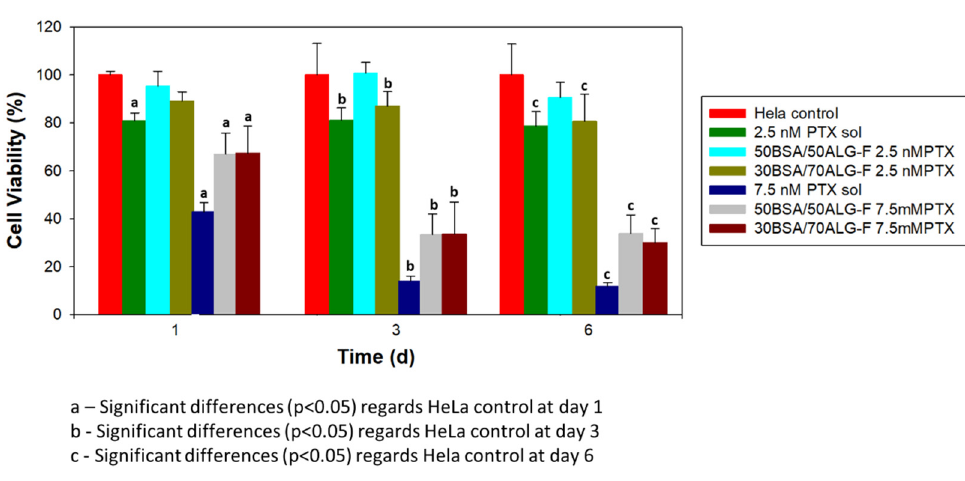
Figure 4. Cell viability of MCF-7, MDA-MB-231 and HeLa cells in the presence of paclitaxel (PTX) in solution and PTX-loaded